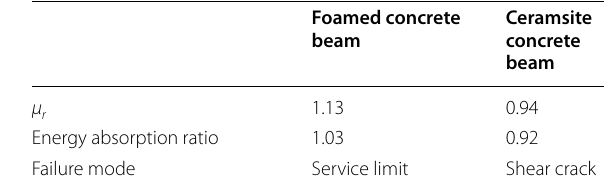
Table 4 Experimental results of the lightweight